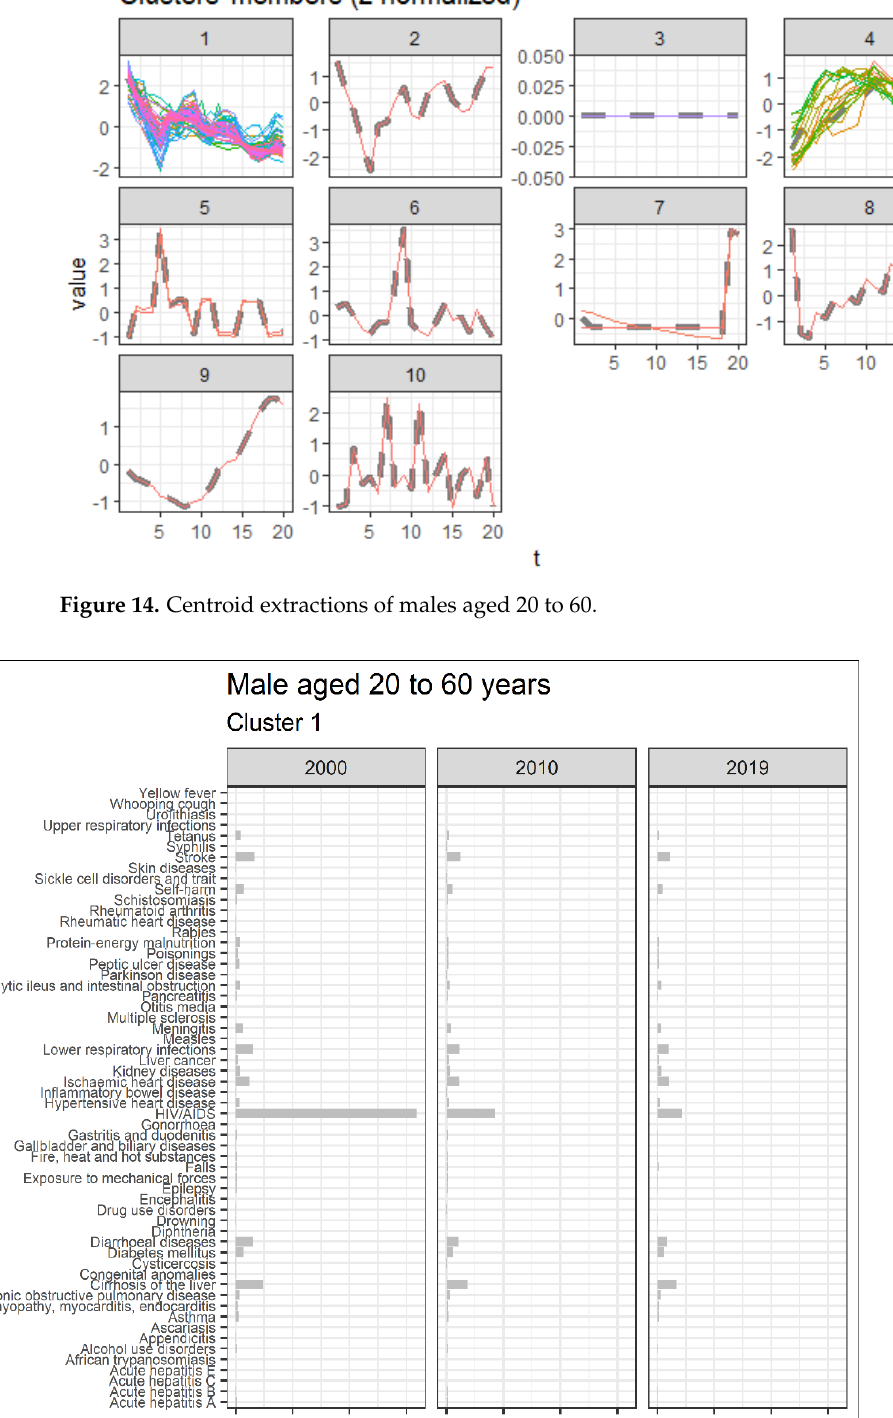
Figure 16. Unlabelled trend causes among younger males in cluster 4 for 2000, 2010, and 2019. 3.5.4. Males Aged over 60 Males aged 60 and above have cluster 2 trending upwards while cluster 1 is declining, as shown by Figure 17. Cluster 3, 5, and 6 are outliers, while four is insignificant. Figure 18 shows the average death rates of the causes of death in cluster 1 among males aged over 60 years partitioned in 2000, 2010, and 2019. However, the leading cause of death is stroke at a